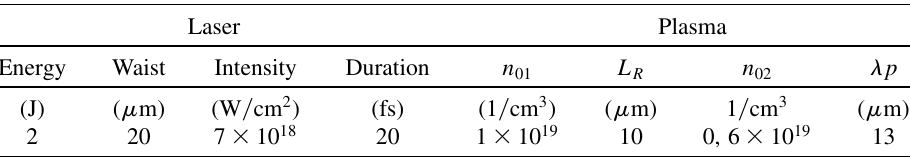
TABLE I. Values of the characteristics of laser and plasma. Laser